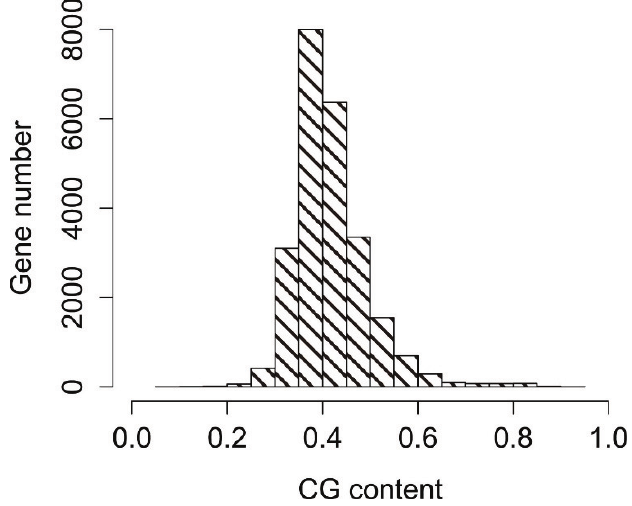
Figure 1. Distribution of the GC contents of reconstructed genes in P . lactiflora .